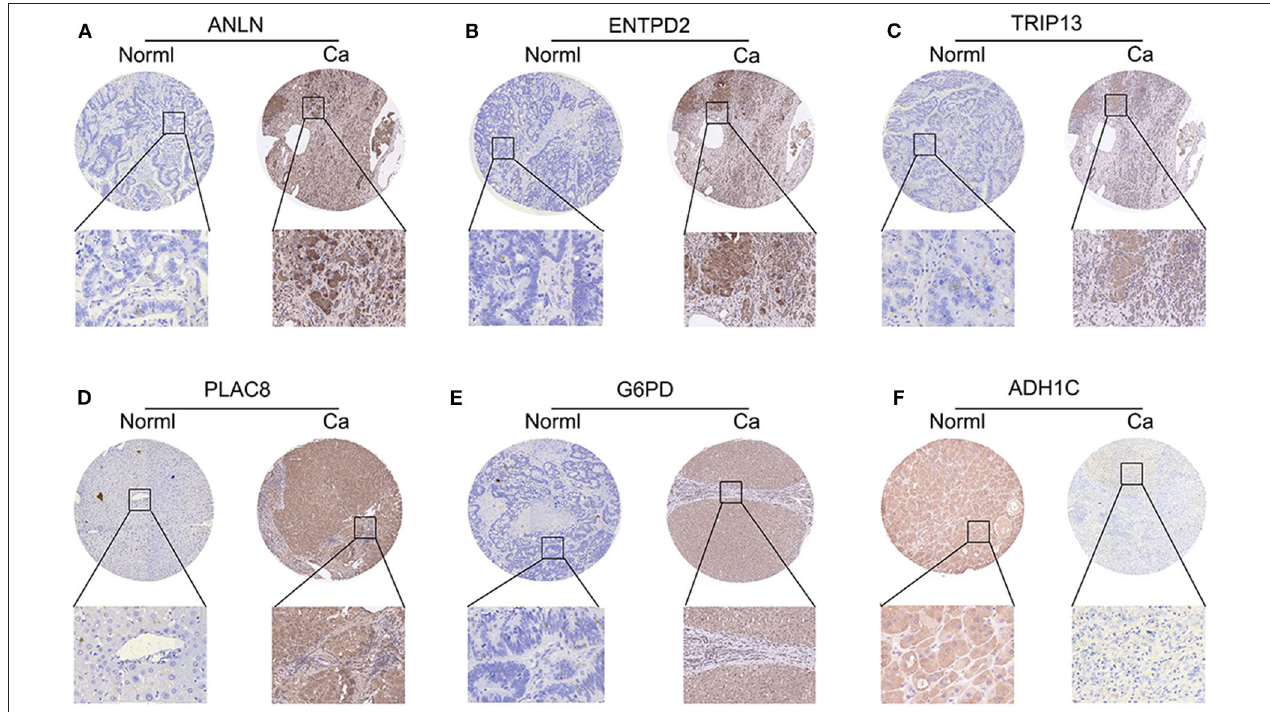
FIGURE 7 | The results of immunohistochemistry in six genes. (A–E) ANLN, ENTPD2, TRIP13, PLAC8, and G6PD were highly expressed in HCC tissues. (F) ADH1C was lowly expressed in HCC tissues.